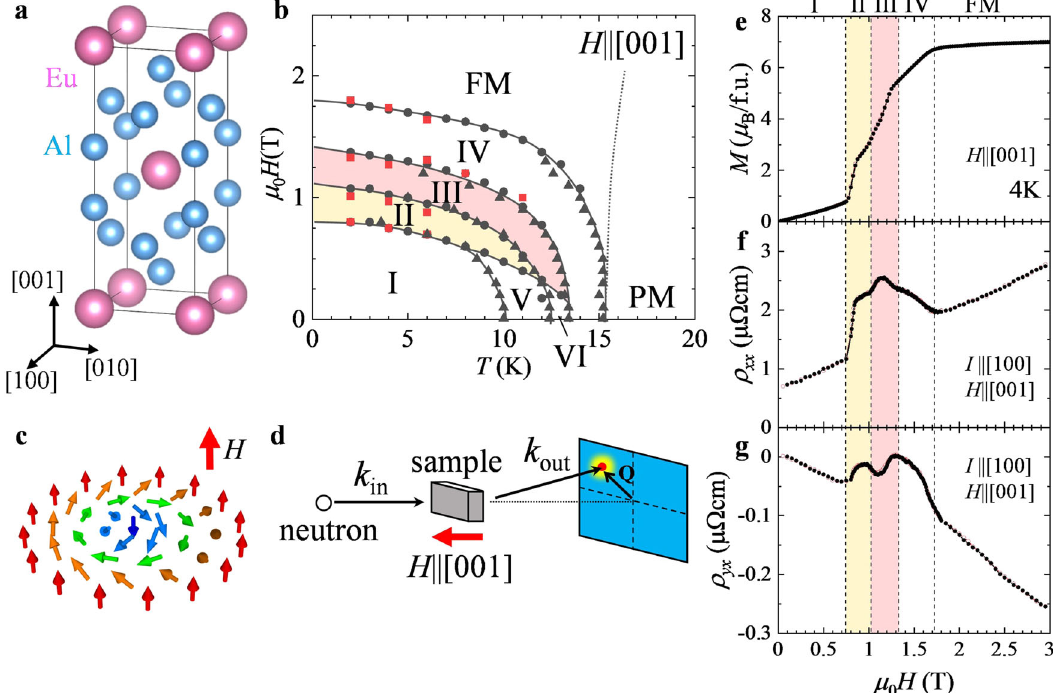
Fig. 1 Magnetic phase diagram of EuAl 4 . a Crystal structure of EuAl 4 . b H (magnetic fi eld)- T (temperature) phase diagram for H || [001] determined from T and H dependences of magnetization, M (black triangular and circle symbols, respectively), and the H dependence of Hall resistivity, ρ yx (red square symbols). FM and PM represent the ferromagnetic and paramagnetic states, respectively. c Schematic illustration of the skyrmion spin texture. d Schematic illustration of the experimental geometry for the SANS measurement. k in and k out are the incident and scattered neutron wave vectors, respectively. e – g Magnetic- fi eld dependence of magnetization M ( e ), longitudinal resistivity ρ xx ( f ), and Hall resistivity ρ yx ( g ) at 4 K for H || [001] and I || [100]. Black fi lled and red open circles correspond to the fi eld-increasing and -decreasing processes,